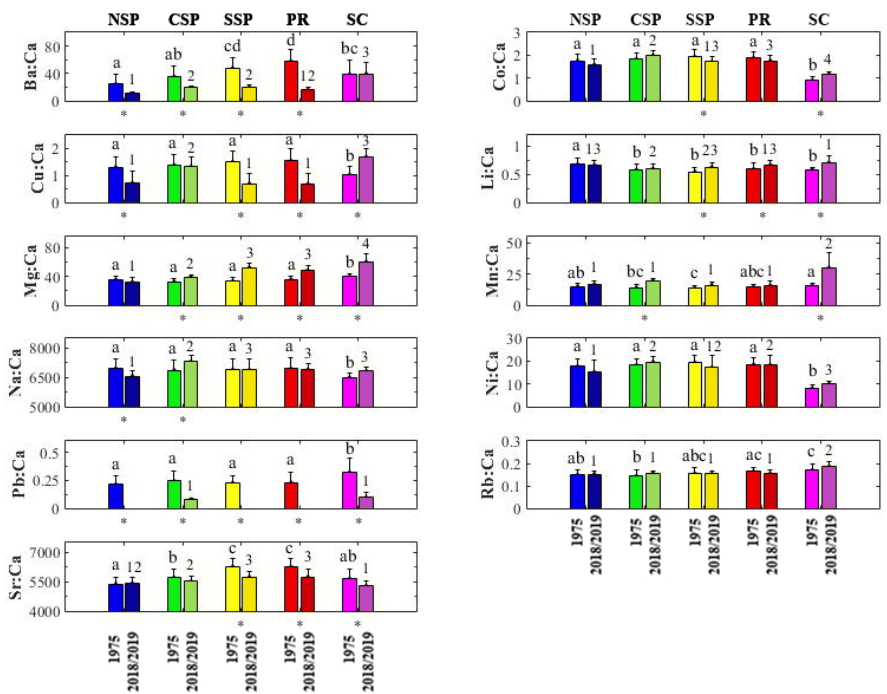
Figure 2. Element:Ca ratios in otoliths of Isopisthus parvipinnis collected in the South Brazil Bight in 1975 and 2018/2019. Locations sharing the same letter (year 1975) or number (year 2018/2019) do not show any statistical difference (Two-Way ANOVA, Tukey’s post-hoc tests, p > 0.05). Significant time differences in each location are shown by an asterisk (*) (Two-Way ANOVA, Tukey’s post-hoc tests, p < 0.05). Data are presented as mean values ± SE. Legend: North of São Paulo (NSP), Center of São Paulo (CSP), South of São Paulo (SSP), Paraná (PR), Santa Catarina (SC).